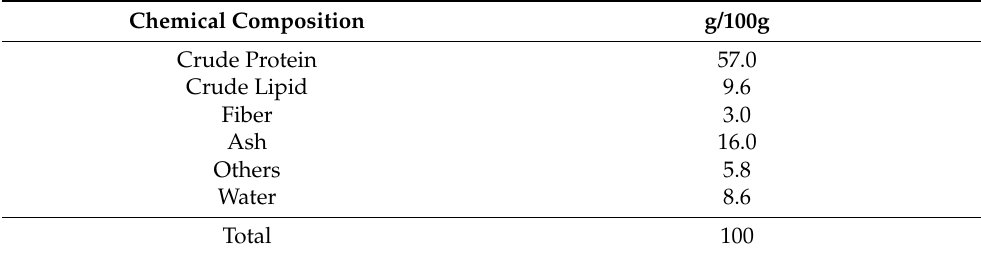
Table 1. Ingredient composition of the standard diet.